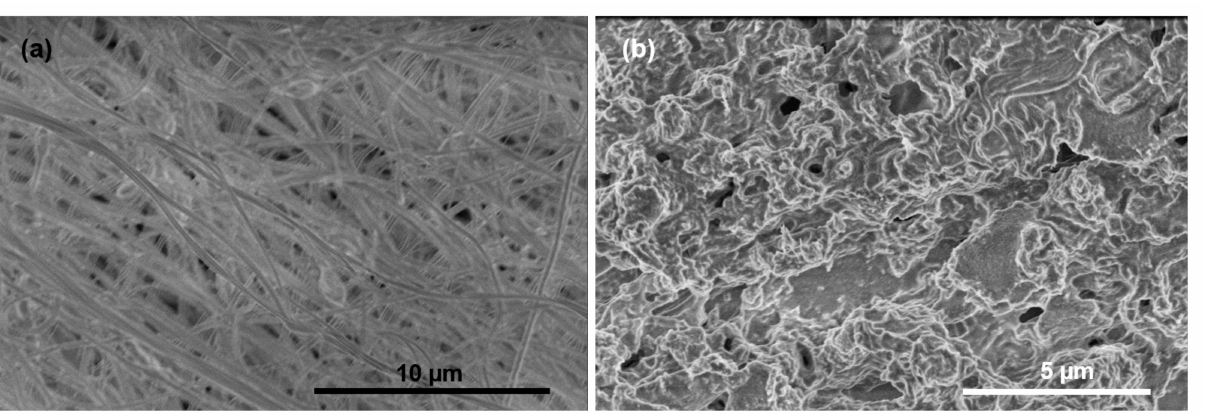
Figure 8. FESEM images of ( a ) as-received PBI and ( b ) PBI after the laser annealing